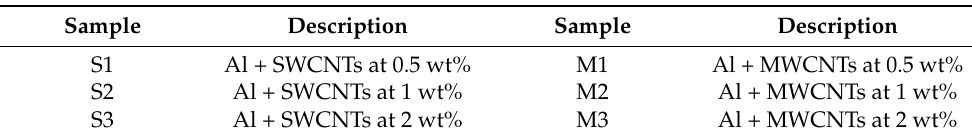
Table 1. Description of the high-energy ball-milled Al-based carbon nanotube (CNT) nanocomposite